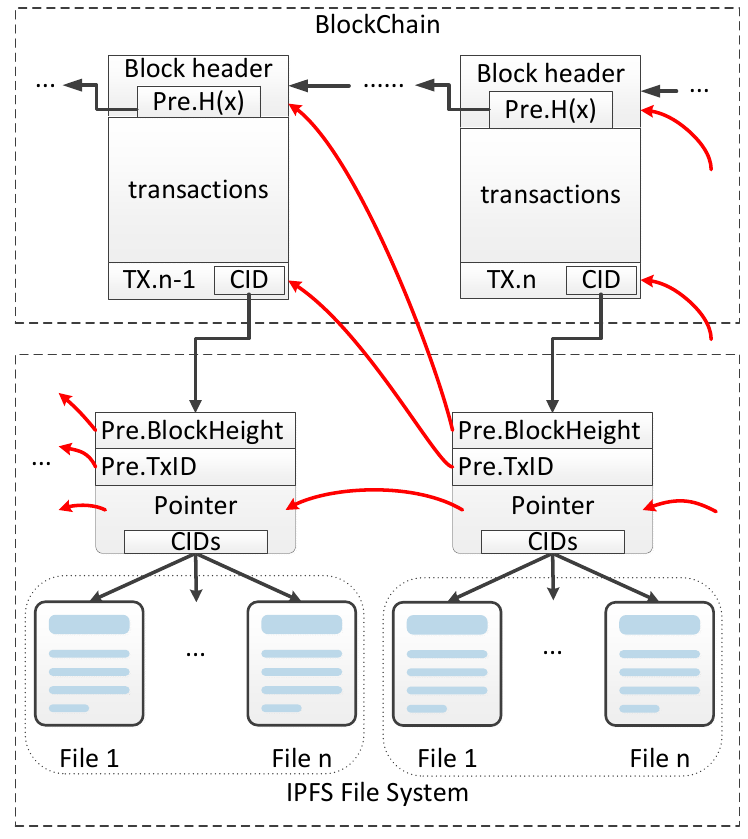
Figure 2. Pointer design.